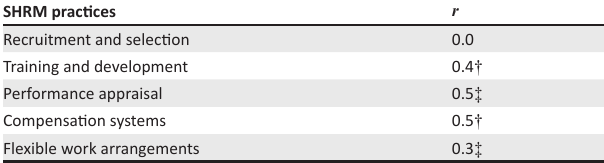
TABLE 2: Correlations between SHRM practices and motivation.